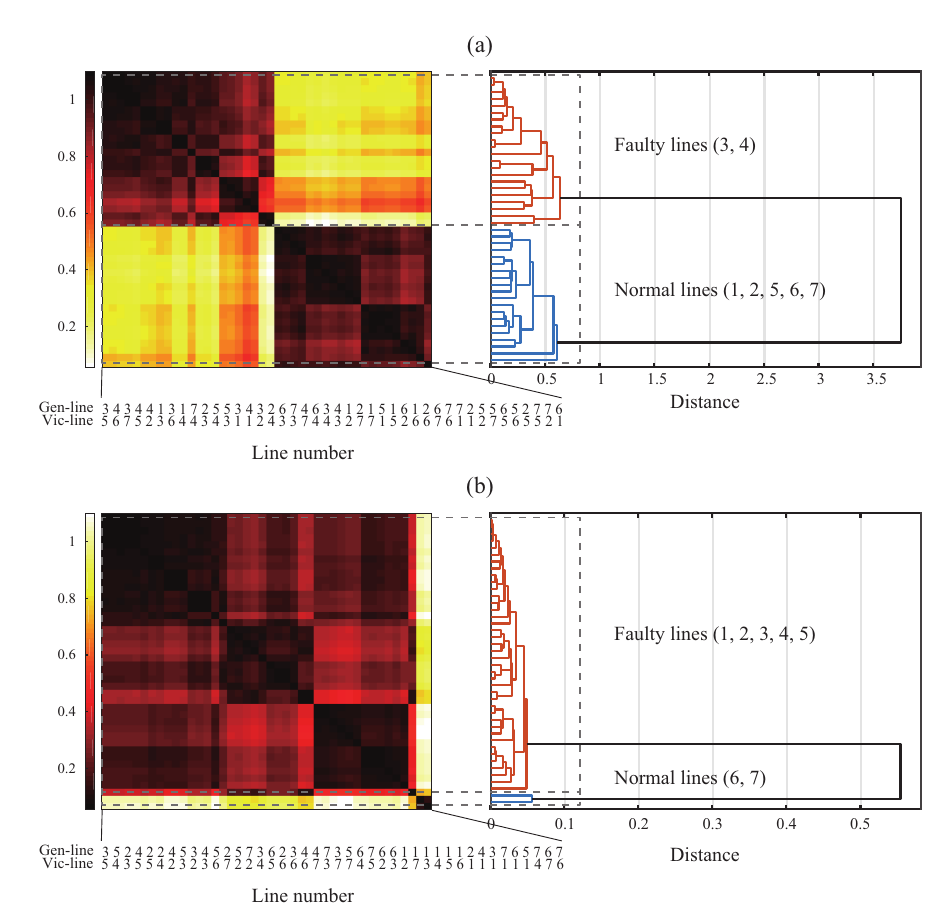
Figure 9. Faulty line classification results: ( a ) hierarchy clustering results when Lines 3, 4 are opened and ( b ) hierarchy clustering results when Lines 1, 2, 3, 4, and 5 are